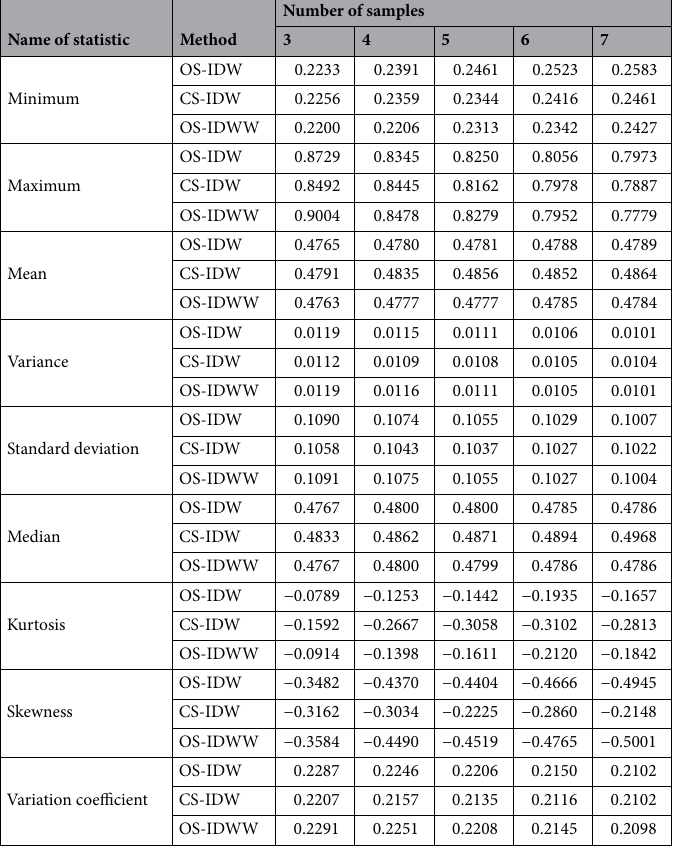
Table 2. Statistics of the Li grade estimation